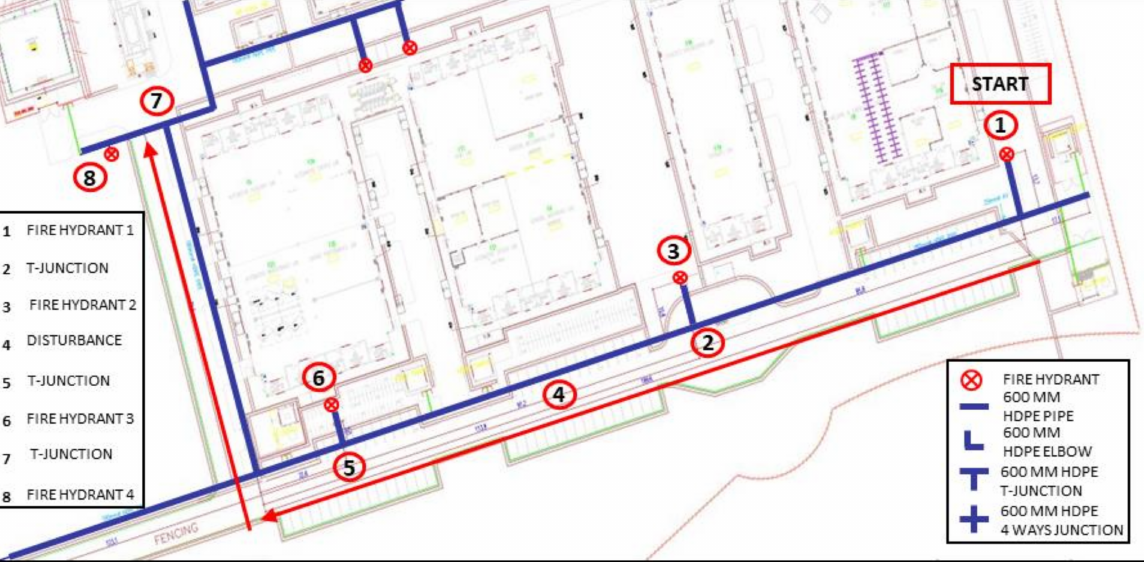
Figure 6. Pipeline Network Blueprint at Faculty of Mechanical and Automotive Engineering Technology, Universiti Malaysia Pahang.